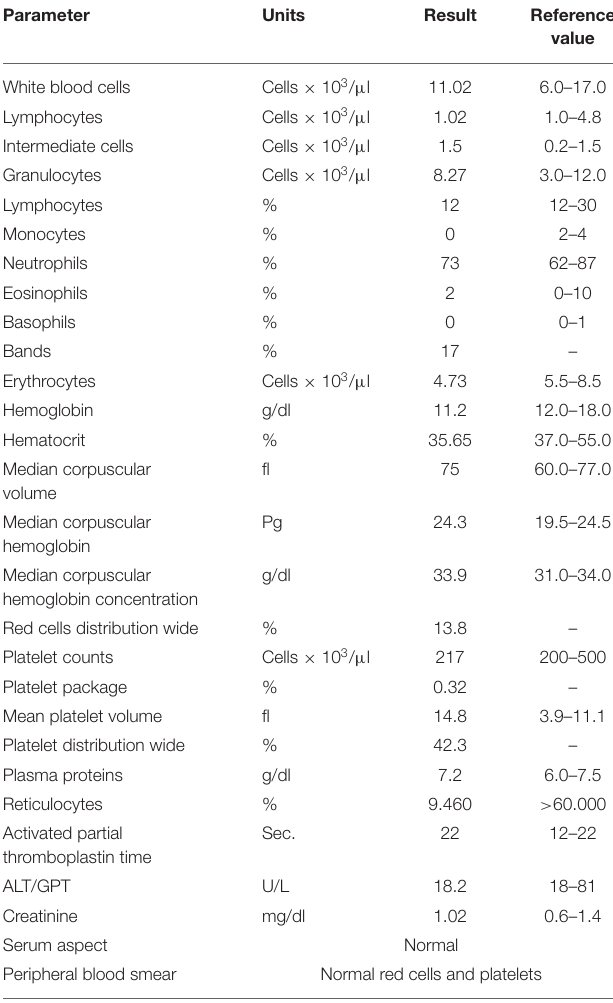
TABLE 1 | Results of blood cell counts and blood biochemistry